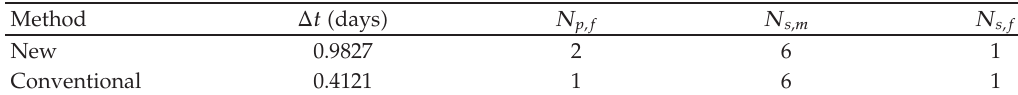
Table 2: Comparison of Example